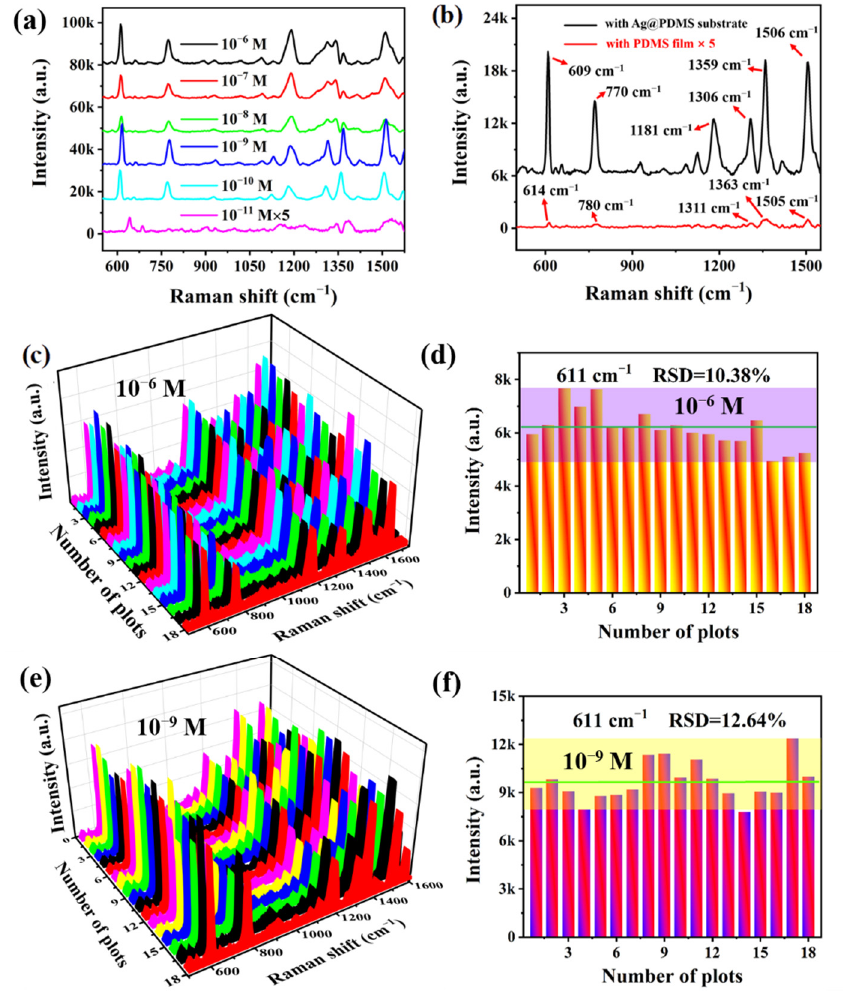
Figure 5. SERS performances of Ag (315) @PDMS substrate. ( a ) SERS spectra of different concentrations R6G adsorbed on the Ag (315) @PDMS substrate. ( b ) The SERS spectrum of 10 − 10 M R6G adsorbed on the Ag (315) @PDMS substrate and Raman spectrum of 10 − 3 M R6G adsorbed on the PDMS film. ( c , e ) SERS spectra of 10 − 6 and 10 − 9 M R6G solution obtained from 18 randomly selected positions from 3 Ag (315) @PDMS substrates. ( d , f ) The signal intensity distribution at the Raman characteristic peak of 611 cm − 1 in Figure 6c,e.